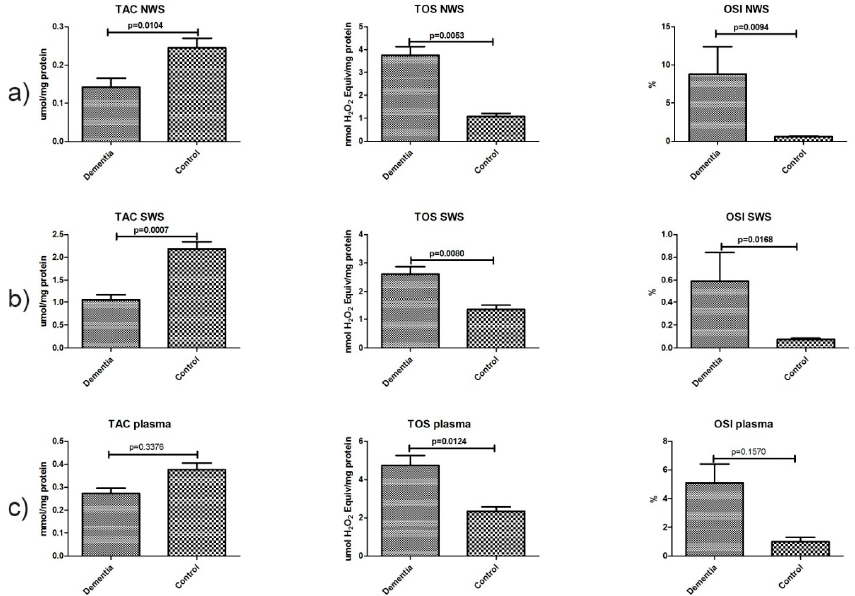
Figure 3. Total antioxidant/oxidant status in non-stimulated ( a ) and stimulated ( b ) saliva as well as plasma ( c ) of dementia patients and the control group. Abbreviations: NWS, non-stimulated whole saliva; OSI, oxidative stress index; SWS, stimulated whole saliva; TAC, total antioxidant capacity; TOS, total oxidant status.